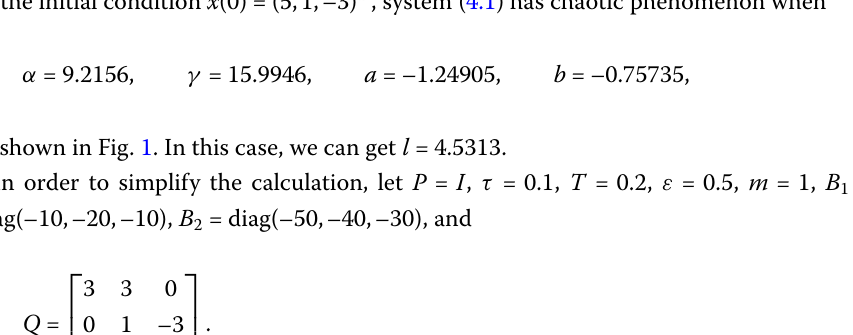
In the initial condition x (0) = (5,1,–3) T , system (4.1) has chaotic phenomenon